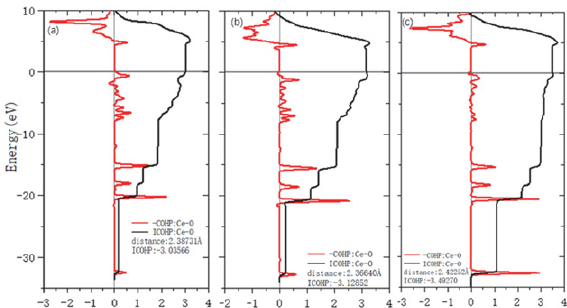
Figure 8. (a) PVP monomer adsorption (001) crystal plane COHP map, (b) PVP monomer adsorption (010) crystal plane COHP map, (c) PVP monomer adsorption (120) crystal plane COHP map